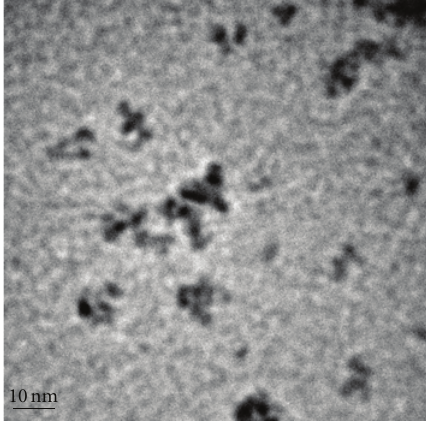
Figure 2: TEM image of the ZnO-MB nanoparticles.